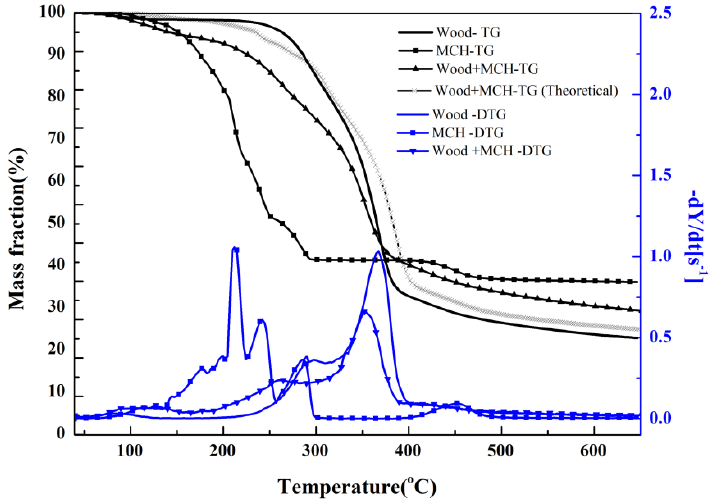
·6H O-treated red gum 2 2